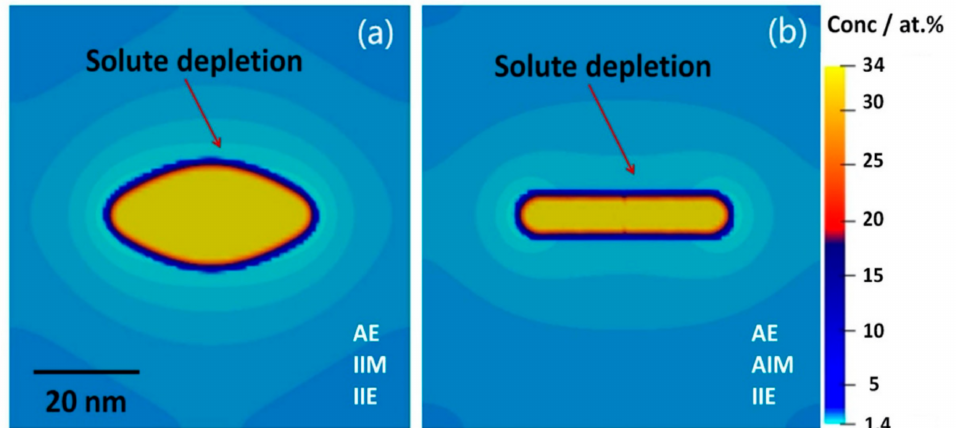
Figure 4. Two-dimensional-cross section of 3D phase-field simulation (concentration field) of the single precipitate in Al-1.69 at.% Cu alloy annealed at 453 K. ( a ) anisotropic elasticity (AE), isotropic interfacial mobility (IIM) and isotropic interfacial energy (IIE) and ( b ) AE, anisotropic interfacial mobility (AIM) and IIE.